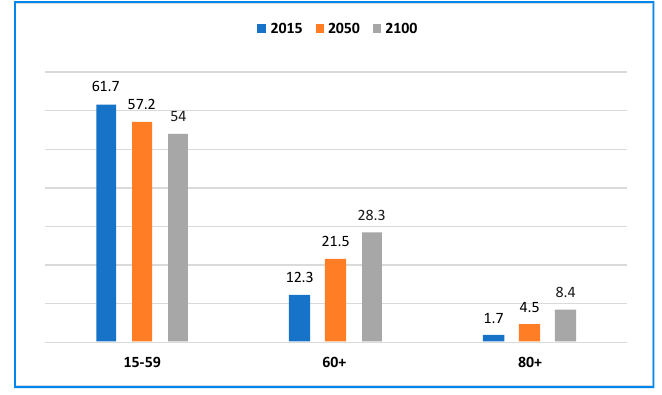
Figure 1. Percentages of persons of different ages in the world in different years [1].